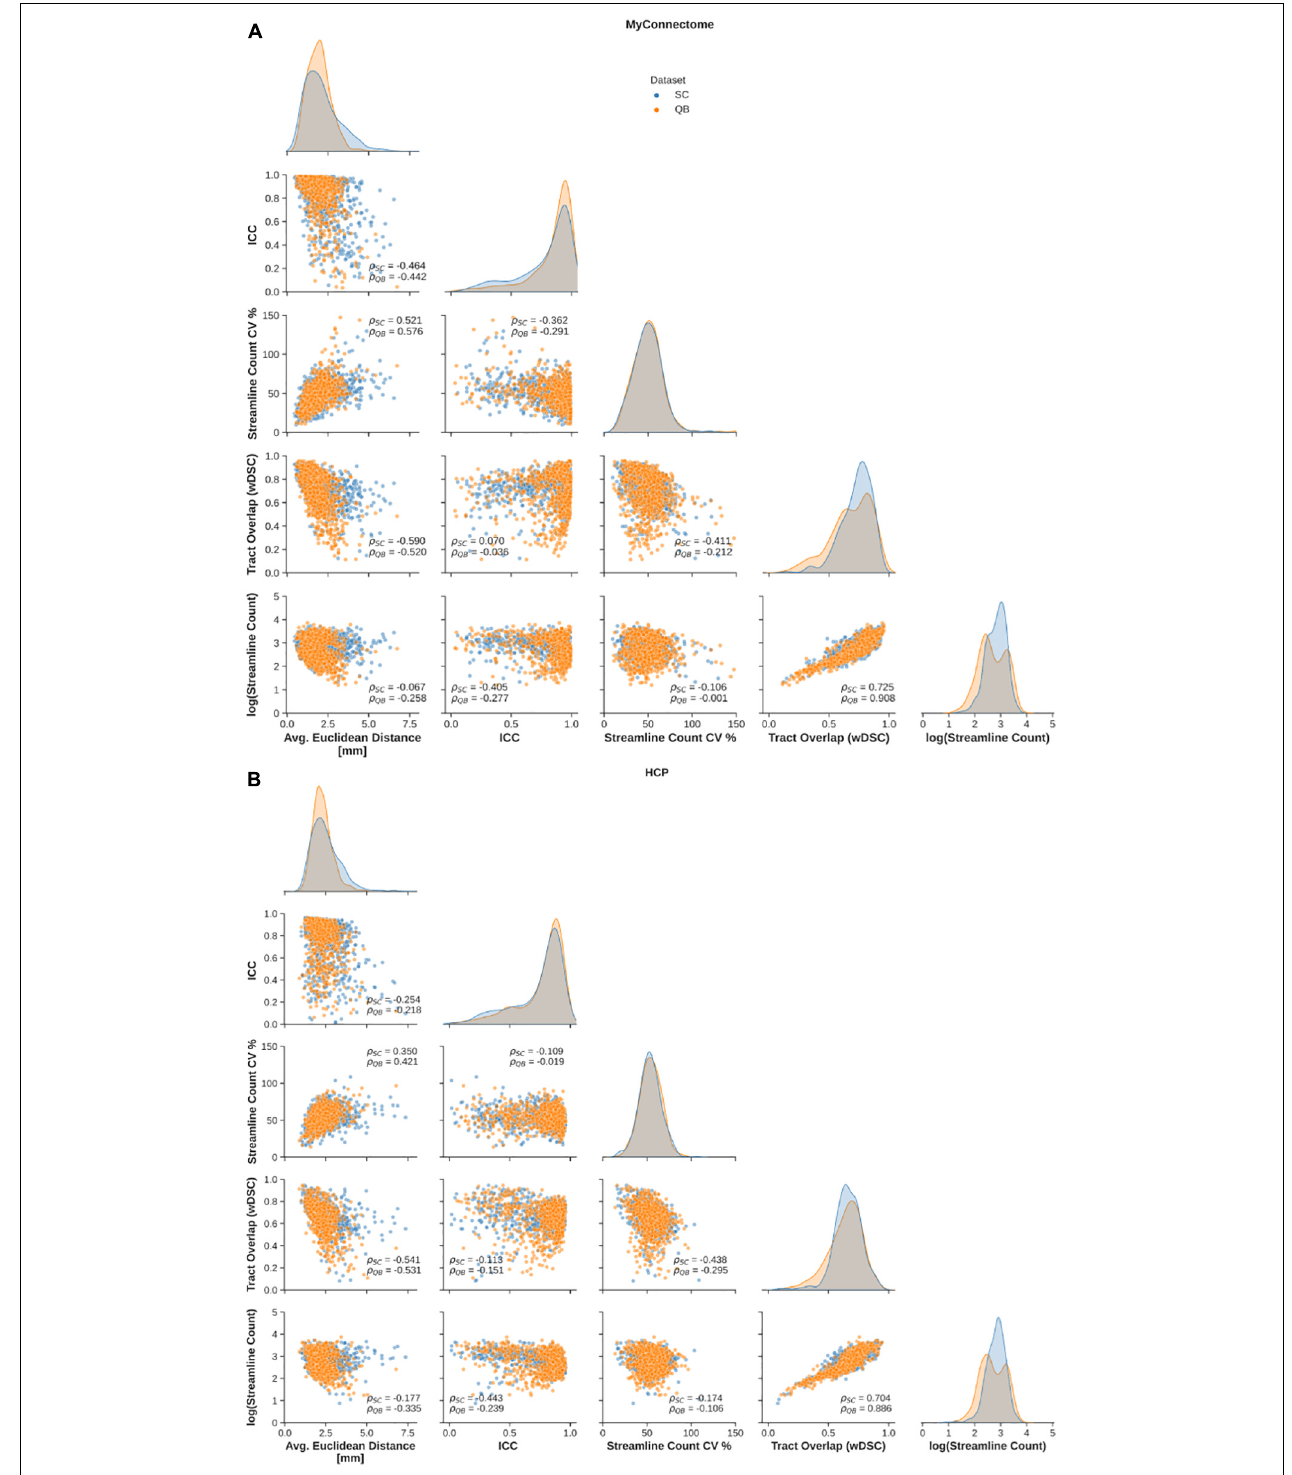
FIGURE 3 | Spearman correlations are computed to explore relationships of metrics employed to assess reliability of spectral clustered (blue circles) and QuickBundle clustered (orange circles) identified tracts via whole-brain tractography. Relationships between different metrics used for assessment are shown in pairplots for (A) MyConnectome and (B) HCP datasets. Relationships between various metrics and average Euclidean distance from an average tract centroid (left-most), relationships with along-tract absolute agreement (ICC; middle-left column), relationships with streamline count variability (middle-column), and with voxel-wise spatial overlap (middle-right column) are displayed. Distribution of observed points for a given metric (matching the x-axis) are plotted along the